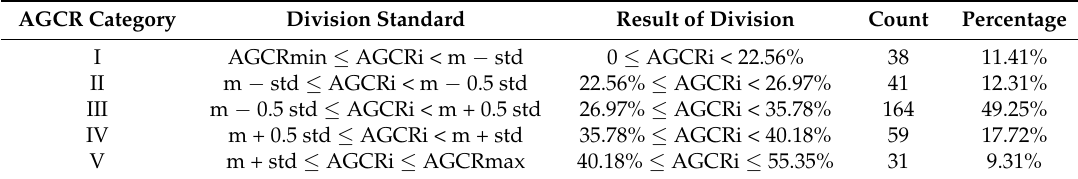
Table 3. The AGCR classification by the standard deviation (STD) method. The AGCR is the average ghost city rate; AGCRi is the AGCR of the ith municipal region; AGCRmax and AGCRmin are the maximum and minimum municipal AGCR values, respectively; m is the mean; and std is the standard deviation of the 333 municipal AGCRs in China.